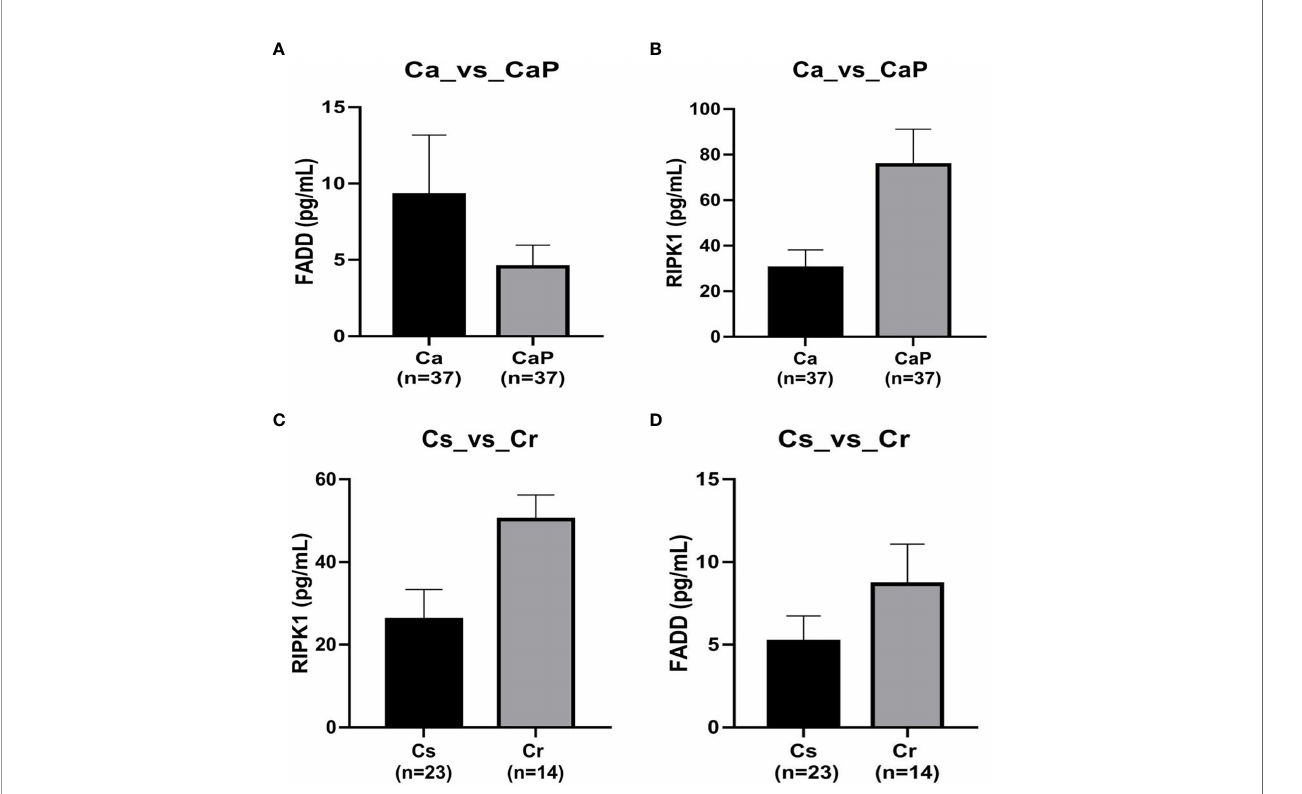
FIGURE 6 | Veri fi cation by ELISA of expression of FADD and RIPK1 proteins in hypopharyngeal squamous cell carcinoma (HSCC) samples. (A) in tissue adjacent to cancer, FADD is more highly expressed in 37 cases of HSCC, P < 0.05. (B) whereas RIPK1 is poorly expressed, P < 0.05. (C) FADD expression was lower in 23 cases of chemotherapy-sensitive patients compared with expression in 14 cases of chemotherapy-resistant patients, P < 0.05. (D) RIPK1 expression was lower in 23 chemotherapy-sensitive patients compared with 14 cases of chemotherapy-resistant patients, P <